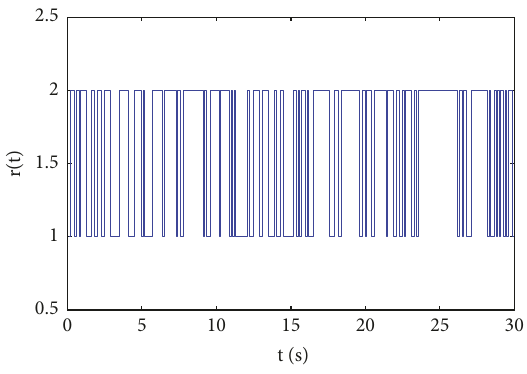
Figure 2: Evolution of Markov